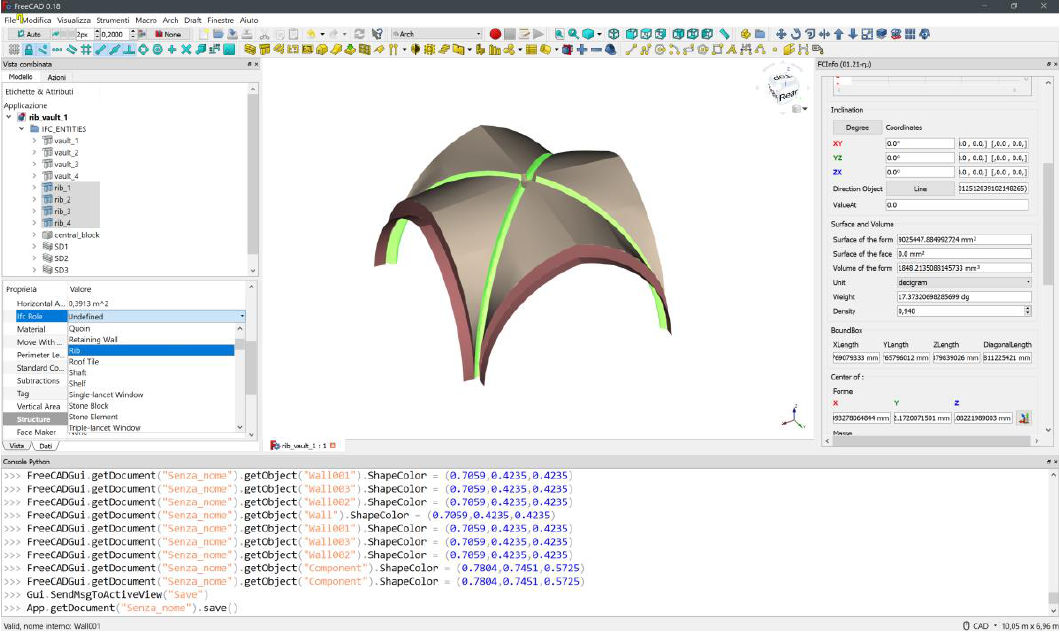
Figure 5. Example of a medieval rib vault: IFC classification of ribs by using custom roles available on the drop-down menu after the implementation.